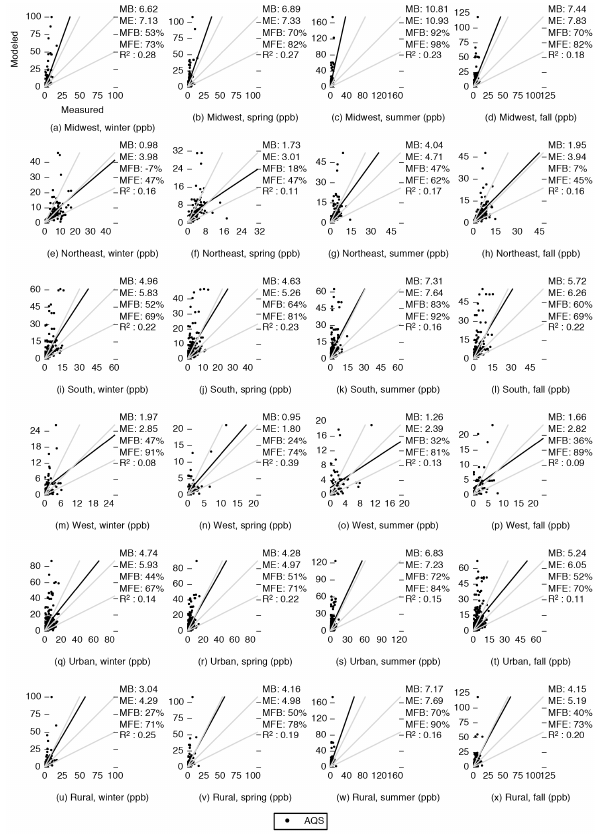
Figure A9. Comparison of modeled and measured NO 2 concentra- tions, disaggregated by region and